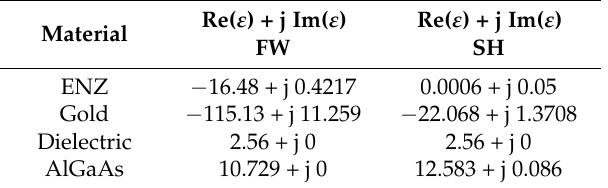
Table 1. Summary of the permittivities of the materials used in this